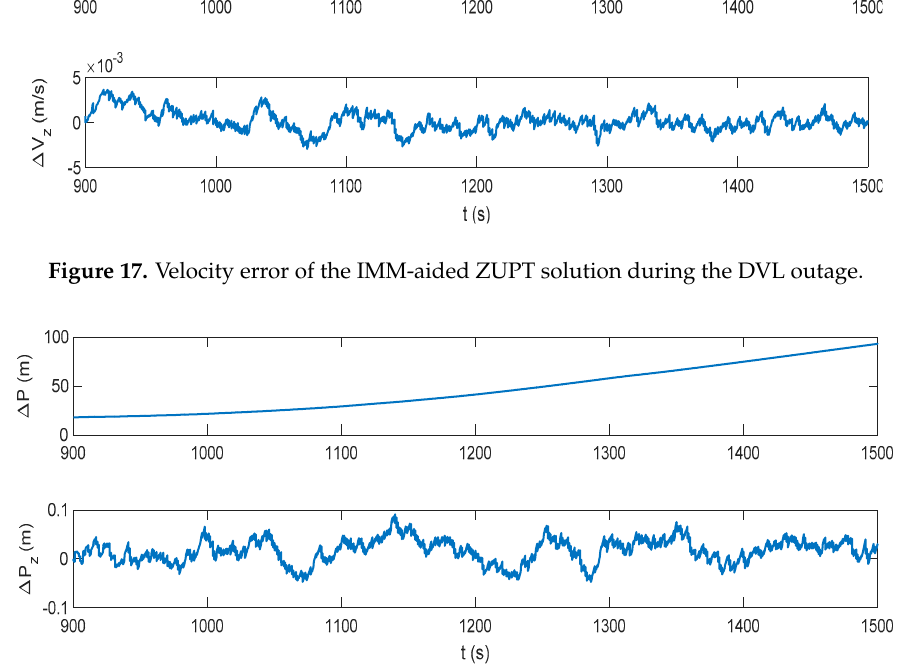
Figure 19. Model probability of the IMM-aided ZUPT solution during DVL outage. 5. Conclusions In this work, an IMM-aided ZUPT algorithm is proposed for INS/DVL integrated navigation system to take the advantages of both ZUPT method and INS/DVL traditional method under the complex underwater environment. Due to the unstable temperature, water density and salinity, the residual errors in the DVL velocity data will influence navigation accuracy of the underwater vehicles. To reduce the negative effect of the DVL velocity error on the whole system, the ZUPT solution is introduced to mitigate the lateral velocity and position errors. However, as a water current often exists, the performance of the ZUPT method would be largely influenced. Thus, IMM algorithm is introduced to form a novel IMM-aided ZUPT methodology to deal with the complex underwater navigation situations. In the proposed algorithm, both INS/DVL model and INS/ZUPT model are constructed and operated in parallel. Through the IMM algorithm, the weights of the two model are calculated according to their innovations and innovation covariance matrices. Thus, the system can employ the two models properly and simultaneously. Meanwhile, the proposed IMM-aided ZUPT solution can also be used when DVL information is unavailable. By setting the corresponding elements of the observation vector to zero, the INS/DVL model turns into the pure INS model, while the ZUPT model for the integration turns into the ZUPT model for the standalone INS. The proposed methodology can continuously improve the navigation accuracy whenever DVL is available. Simulations are conducted to evaluate the proposed algorithm under both the integration period and standalone INS period. It can be seen that the proposed algorithm can leverage the strength of both the INS/DVL model and INS/ZUPT model. It is also effective during DVL outage. The proper model can be clearly seen by the model probability, where the non-ZUPT period can be clearly identified for both the integration period and standalone INS period. To conclude, in the complex underwater environment, where the water current often occurs, the proposed algorithm innovatively employs the ZUPT solution using the IMM algorithm, which is designed and is suitable for the land